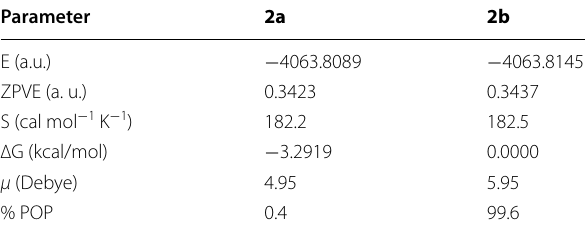
Table 2 The calculated energies and thermodynamic parameters of the studied isomers of 2